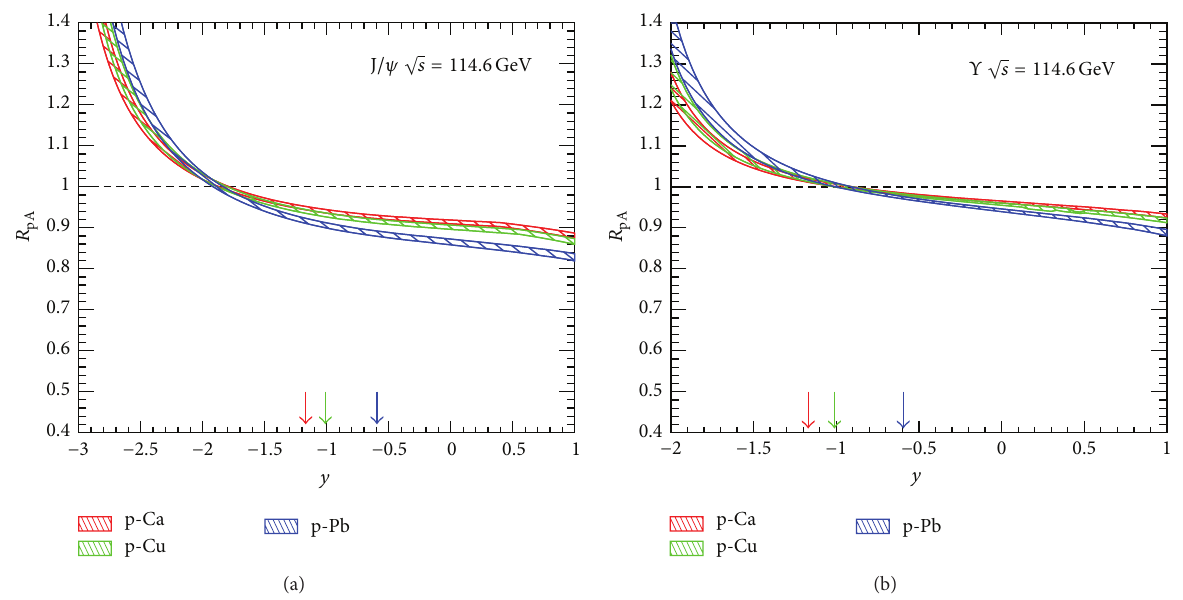
Figure 1: J /𝜓 (a) and Υ (b) suppression in p-Ca, p-Cu, and p-Pb collisions at √𝑠 = 114 . 6 GeV.